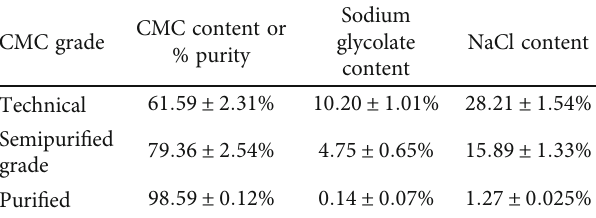
Table 2: CMC, sodium glycolate, and NaCl contents of di ff erent grades of CMC.